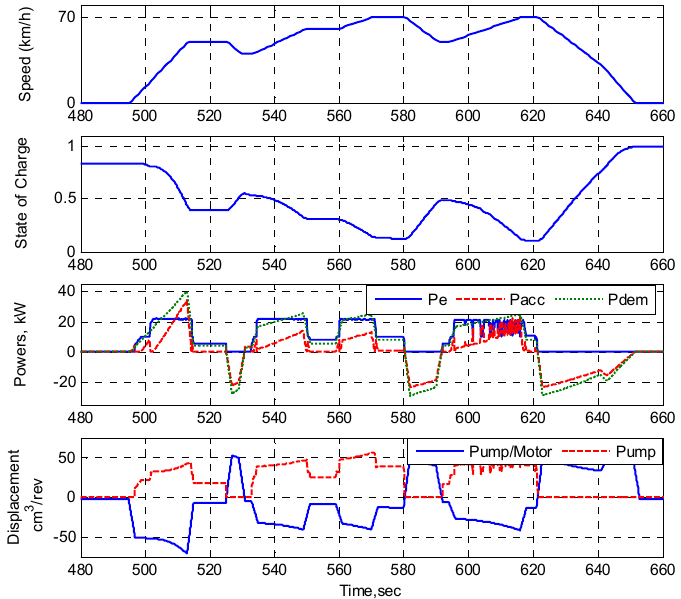
Figure 12. System Behaviors during 480–660 s Intervals of Japan 1015 Driving Cycle.